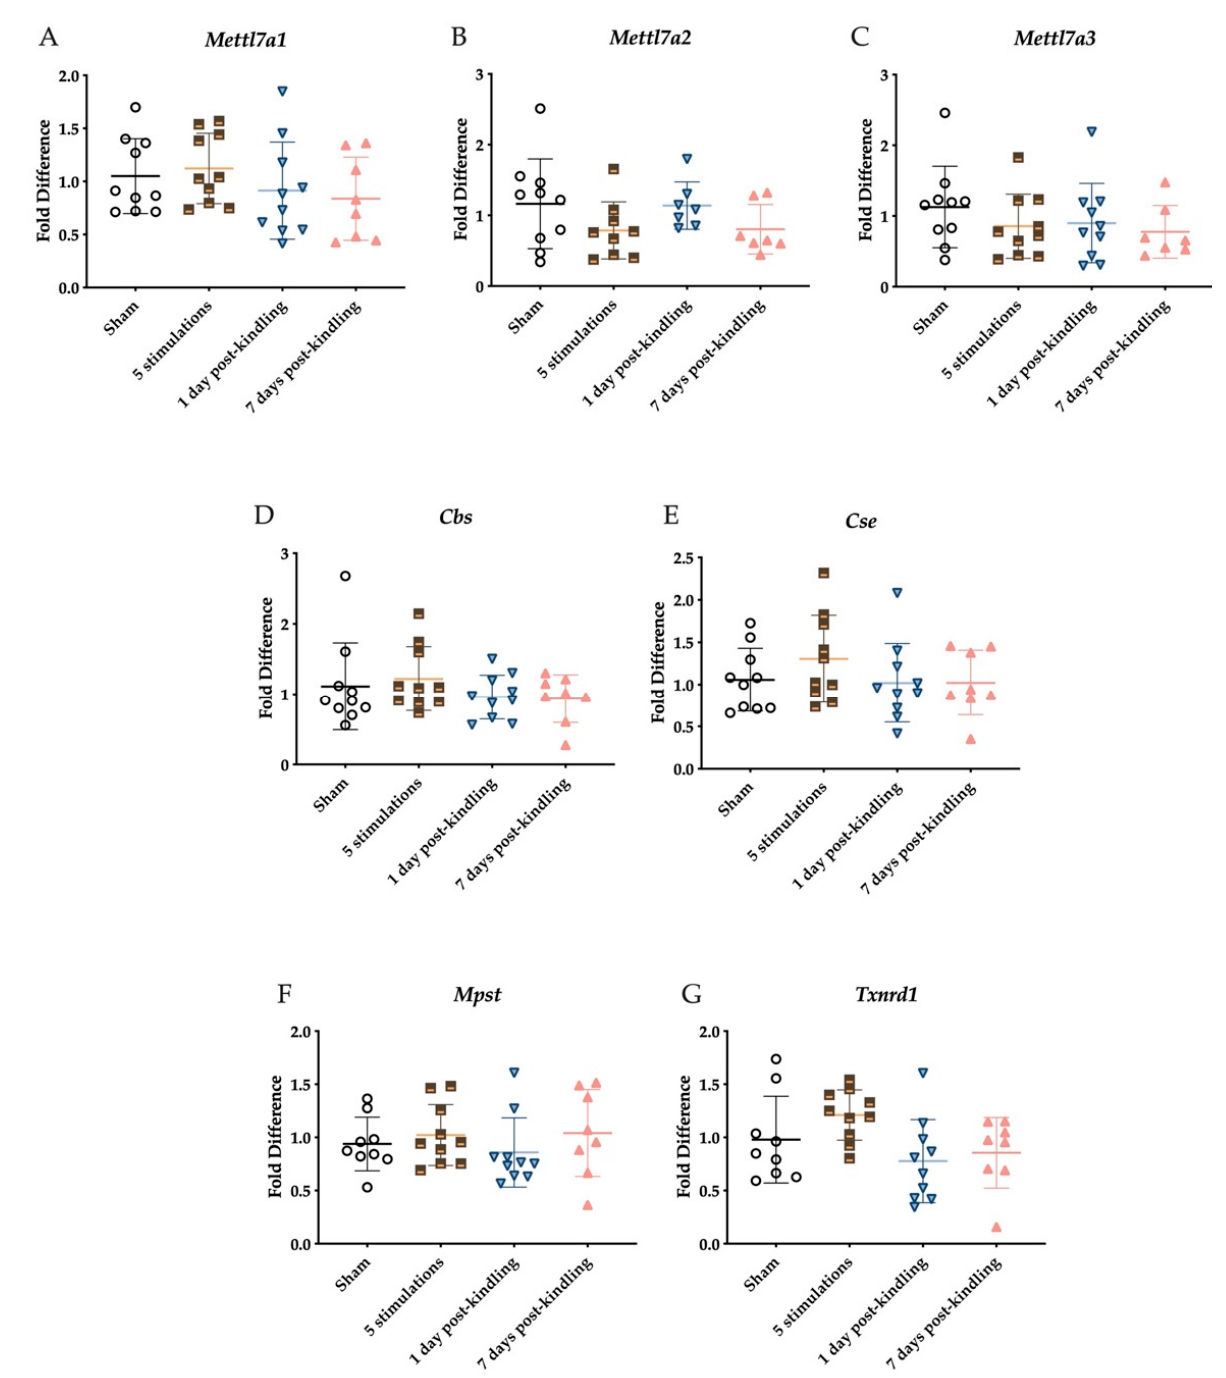
Figure 3. RT-qPCR analysis of genes related to H 2 S production and metabolism in the whole right hemisphere of brains from male mice after corneal kindling. All levels were normalized to the expression of the housekeeping gene, GUSB, and fold difference was normalized to the sham-kindled group. Data are presented as mean +/ − S.E.M. ( A – F ) No significant changes in expression were observed in genes related to H 2 S metabolism, including the Mettl7a isoforms. There were otherwise no significant changes were observed in CBS, CTH, and MPST upon full acquisition of the kindled state. ( G ) There was a significant main effect of kindling on the expression of TXNRD1 (F (3,33) = 2.917, p < 0.05), although post hoc differences between groups were not observed (and thus no *